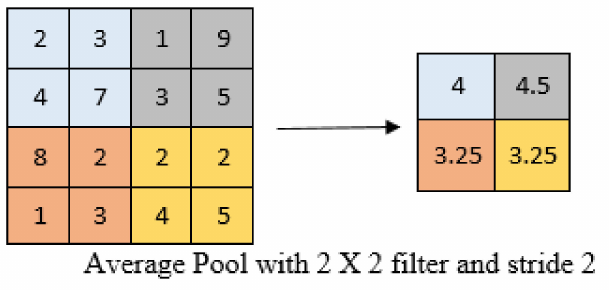
Figure 10. Average pooling